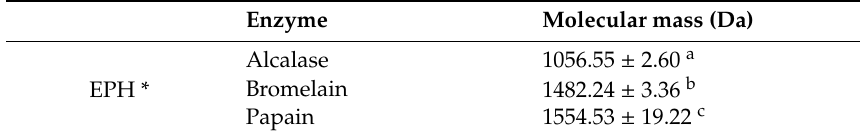
Table 1. Average molecular mass of peptides in eel ( Anguilla marmorata ) following hydrolysis with alcalase, bromelain, and papain 112